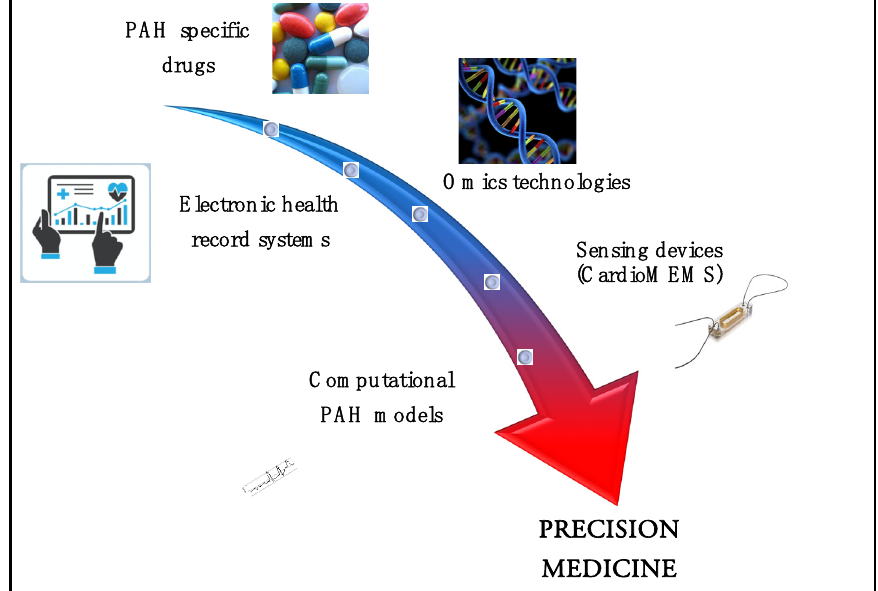
Figure 1. Hypothetical pathway for precision medicine in PAH. Treating the patient, not the disease, is the goal for precision medicine. Panomics, phenotyping, big data derived from electronical health systems and sensing devices, and artificial intelligence with the use of computational simulators could contribute to developing this ambitious goal in PAH, overcoming the current limitations of reductionism.